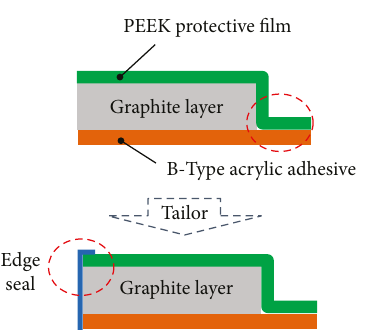
Figure 8: Design of main heat-dissipation path.